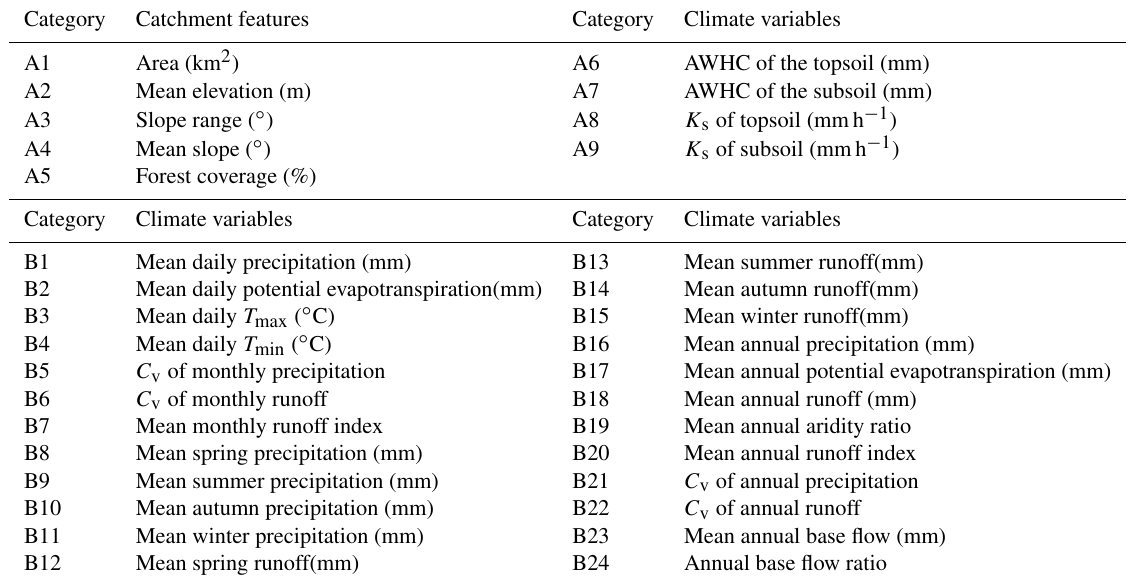
Table 4. Category of the selected variables that may be associated with the changes in the ACWSC. The selected variables were divided into two parts, i.e., catchment features (nine variables) and climate variables (24 variables).